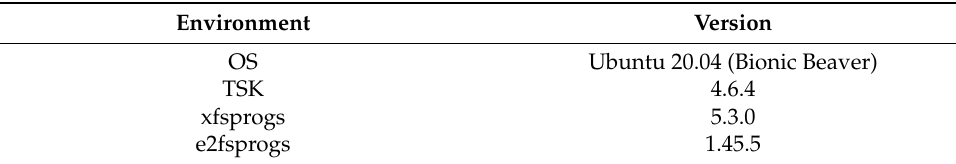
Table 2. Experimental